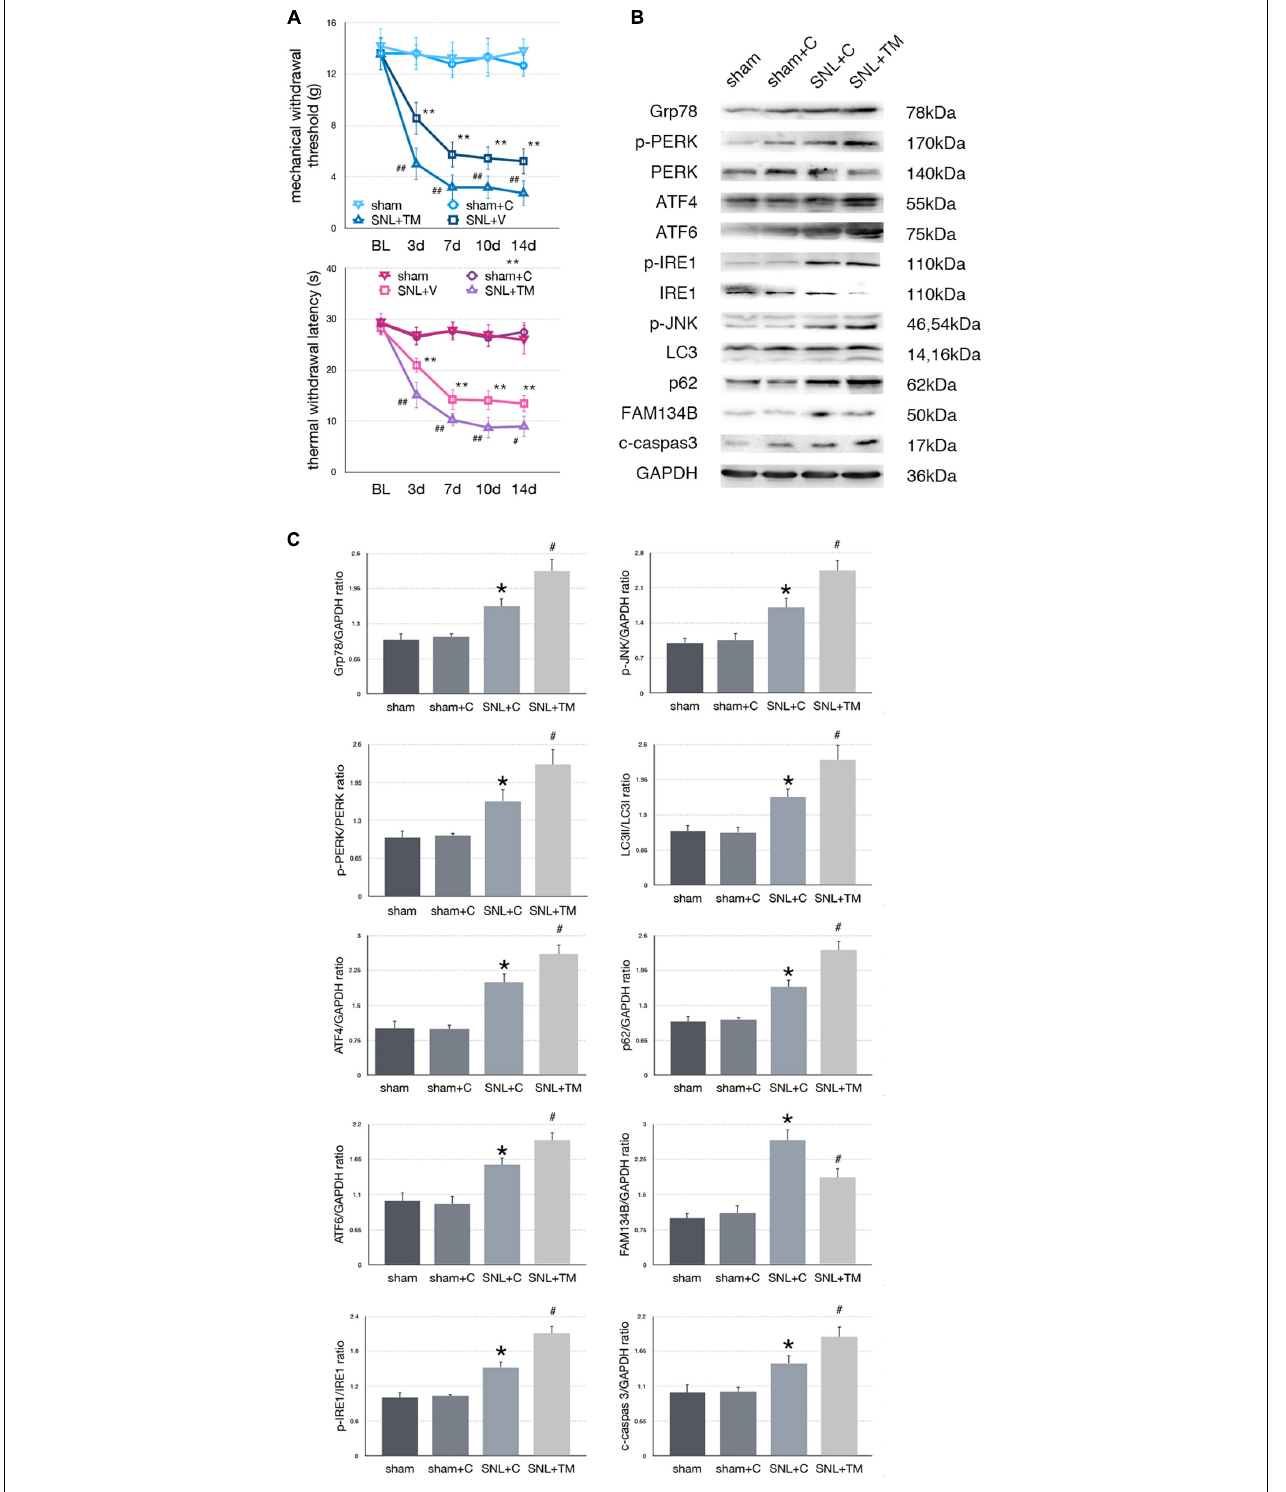
FIGURE 4 | Effect of tunicamycin on pain-related behavior tests and protein expression. (A) Tunicamycin deteriorates TWL and MWT tests. (B) Western blot analysis of protein expressions in spinal cord were shown. (C) Quantifications of Western blot in sham, sham + C, SNL + C, and SNL + TM groups. Application of tunicamycin alters protein expressions in spinal cord are shown. Data are presented as mean ± SD, n = 6 rats per group. sham vs. sham + C have no significant difference; * p < 0.05 SNL + C group vs. sham + C group; # p < 0.05 SNL + TM vs. SNL + C group. In behavior tests, ** p < 0.01, ## p < 0.01.